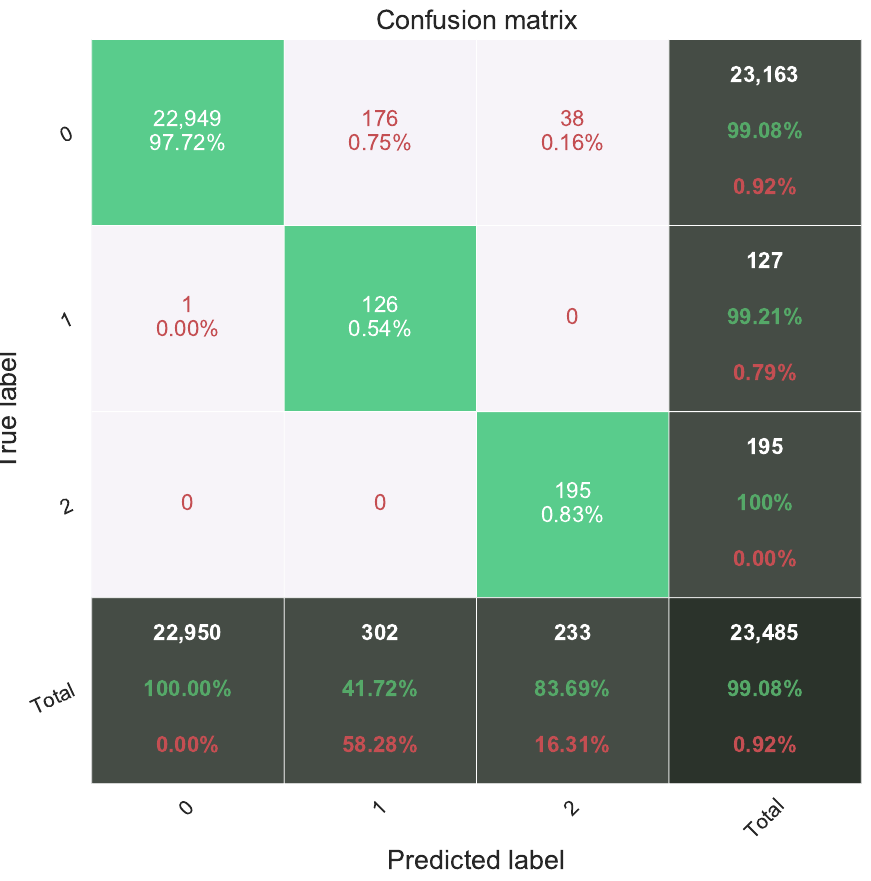
Figure 5. Confusion matrix of custom MLP